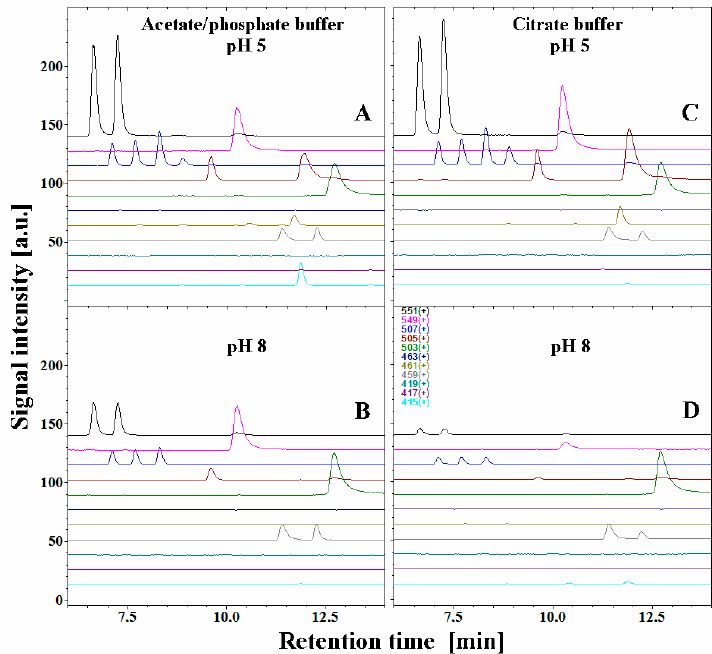
Figure 8. Chromatographic LC-MS profiles of selected ions of betanin as well as its decarboxylated and dehydrogenated derivatives generated in betalain-rich extract after 60-min heating experiments in acetate/phosphate ( A , B ) and citrate buffers ( C , D ) at 85 °C—pH 5 and 8.